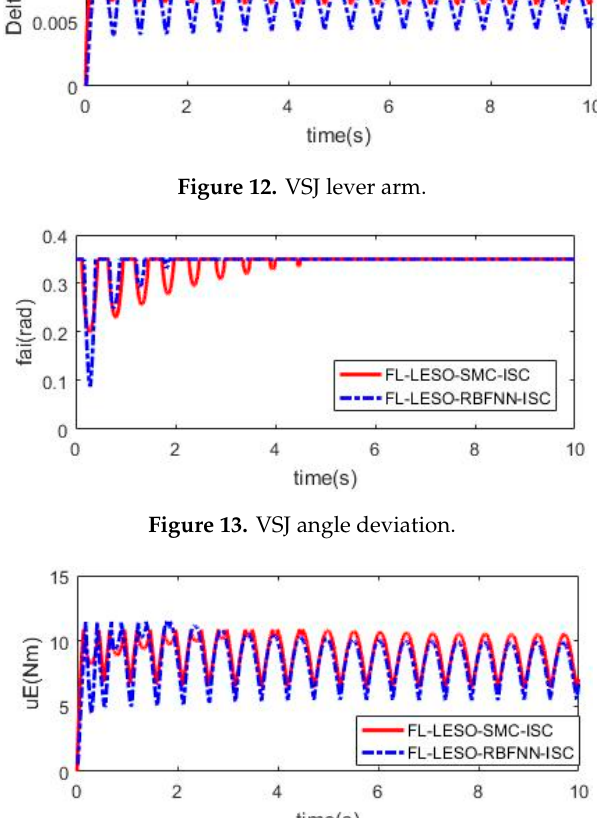
Figure 14. The joint motor elastic Figure 14. the joint motor elastic torque. Figure 14. the joint motor elastic torque. Figure 14. the joint motor elastic torque. Figure 14. the joint motor elastic torque. Figure 14. the joint motor elastic torque. Figure 15. the stiffness motor resistant torque. Figure 15. the stiffness motor resistant torque. Figure 15. the stiffness motor resistant torque. Figure 15. the stiffness motor resistant torque. Figure 15. the stiffness motor resistant torque.